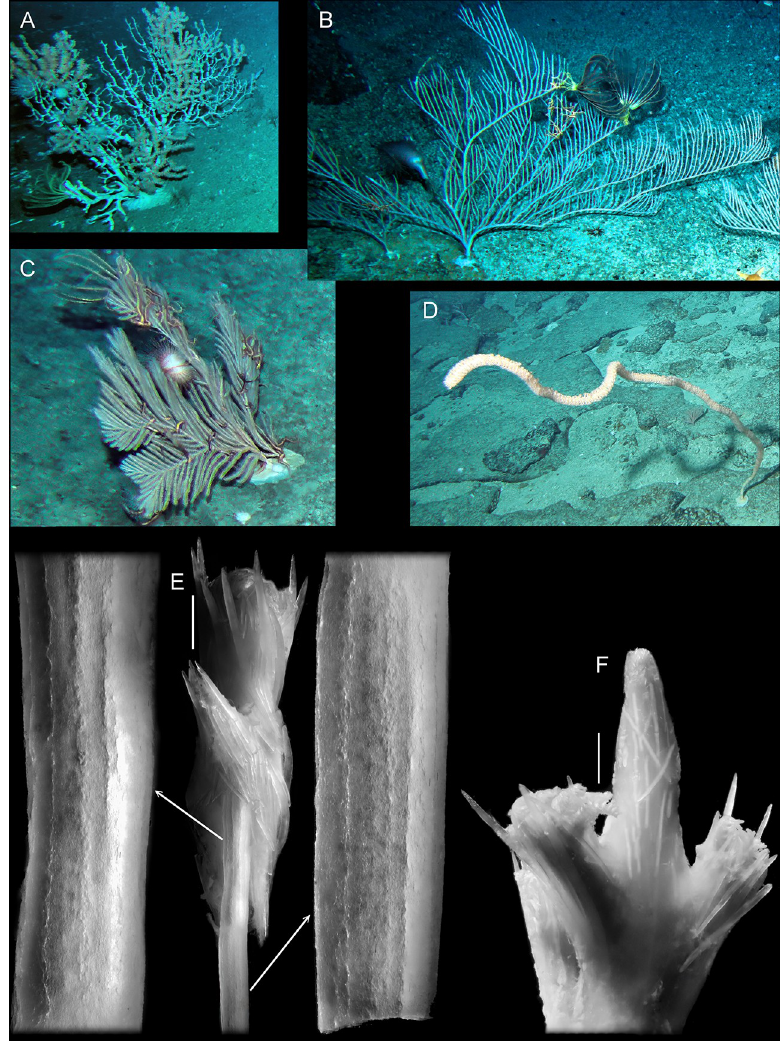
Fig 9. A-D, Underwater images of colonies of some Calcaxonia with a holdfast. A– Keratoisis sp.; B– Paracalyptrophora sp.; C– Callogorgia sp.; D– Lepidisis sp.: E–branch tip of Isidella sp. b with a terminal polyp and close-ups of axial internodes; F–branch tip of Isidella sp. a without terminal polyp. Scale bars 1 mm E-F.